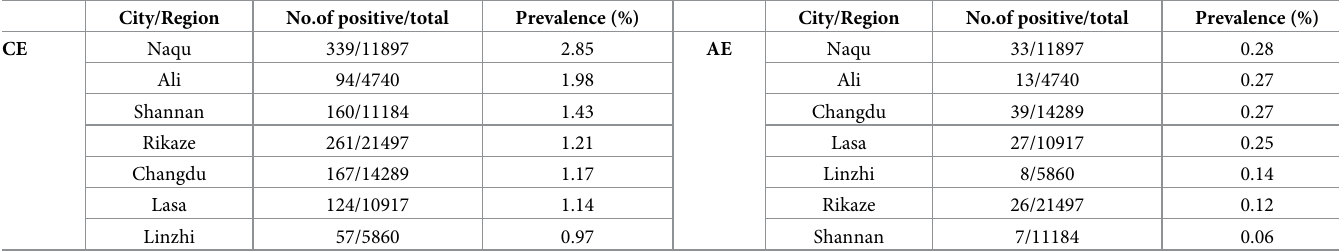
Table 2. Prevalence at city level of CE and AE in Tibet.